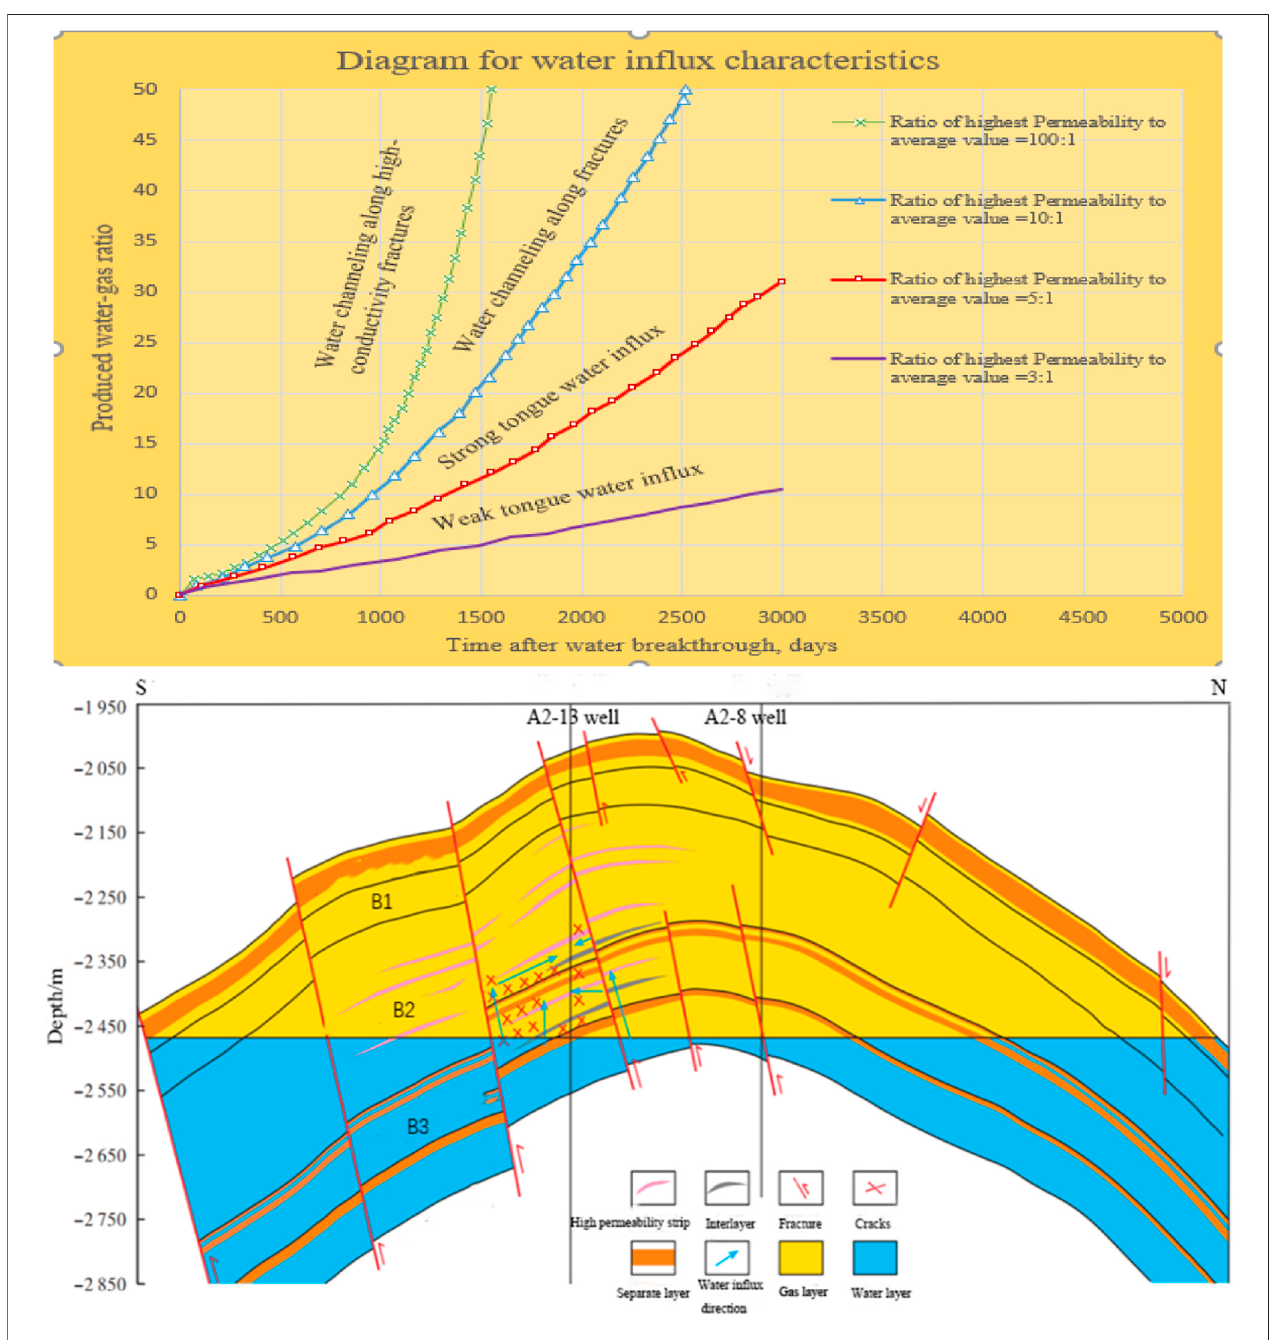
FIGURE 1 | Recognition diagram for water in fl ux modes and schematic for a geological section in a typical gas reservoir.